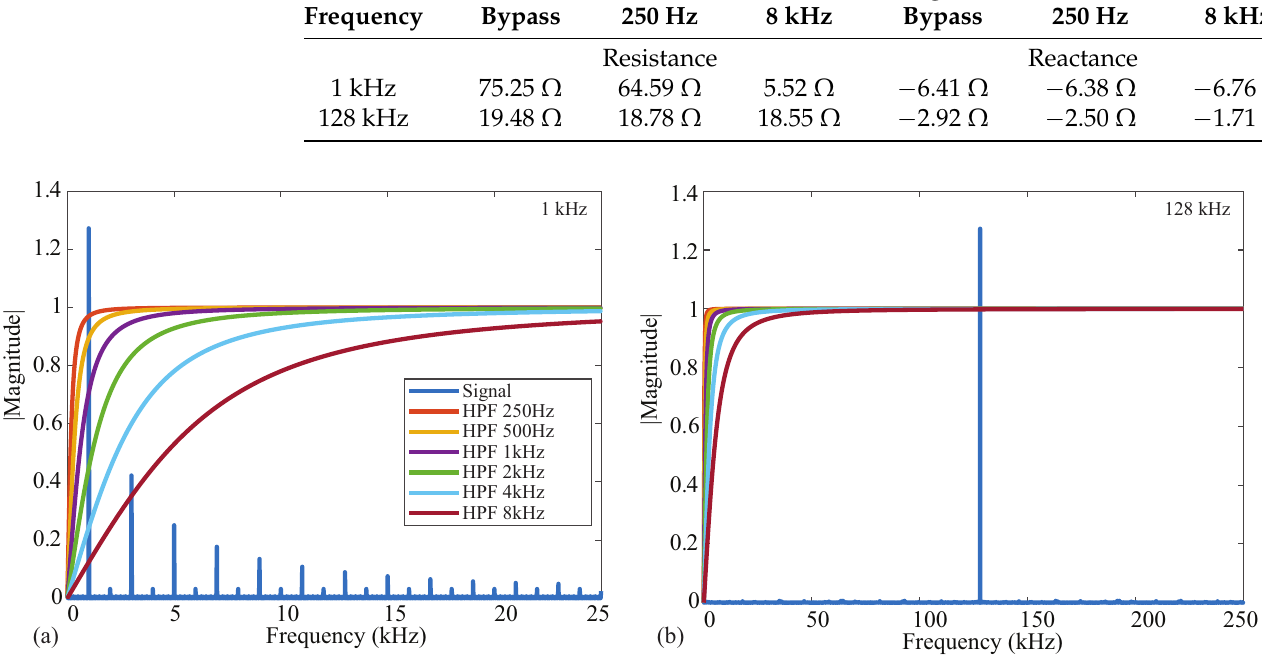
Figure 7. Frequency spectrum of ( a ) 1 kHz and ( b ) 128 kHz square wave signals in comparison to the magnitude response of high-pass filters with cutoff frequencies from 250 Hz to 8